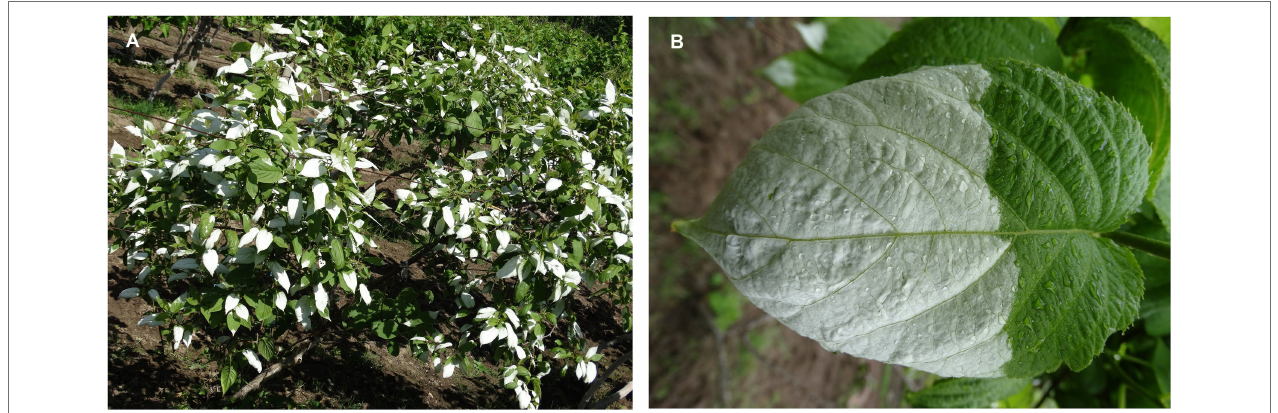
FIGURE 1 | White leaf on reproductive branches in A. kolomikta at flower bud stage (A) and display of white leaf (B)